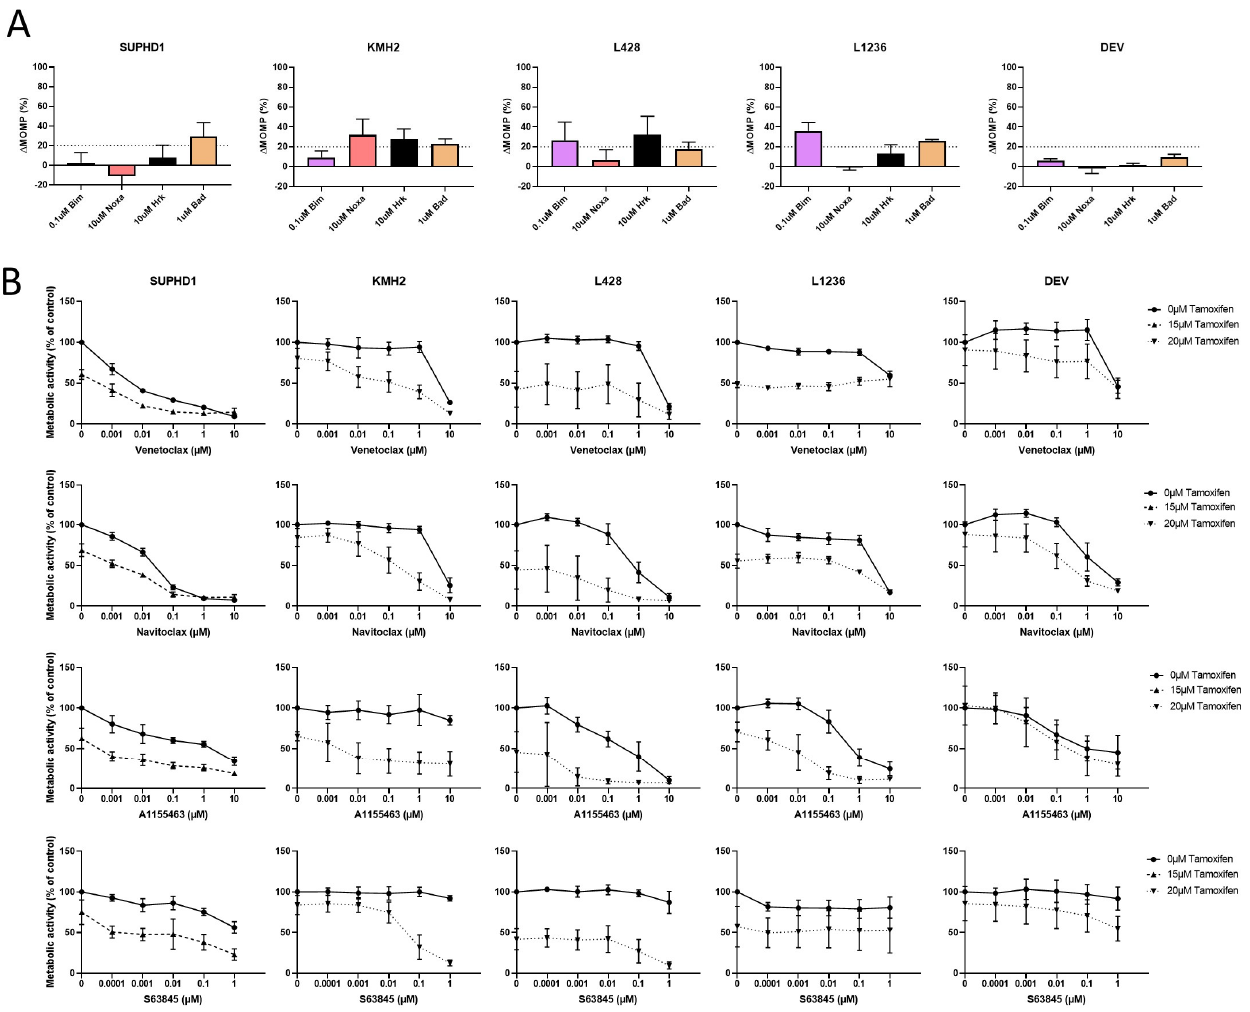
Figure 4. Combination therapy with tamoxifen and BH3 mimetics in HL cell lines. ( A ). Dynamic BH3 profiles for HL cell lines after tamoxifen treatment. Δ MOMP % against 0.1 µM BIM, 10 µM NOXA, 10 µM HRK and 1 µM BAD. ( B ). Combination therapy of tamoxifen with venetoclax, navitoclax, A1155463, and S63845 in HL cell lines. Results are given as metabolic activity normalized to untreated cells .